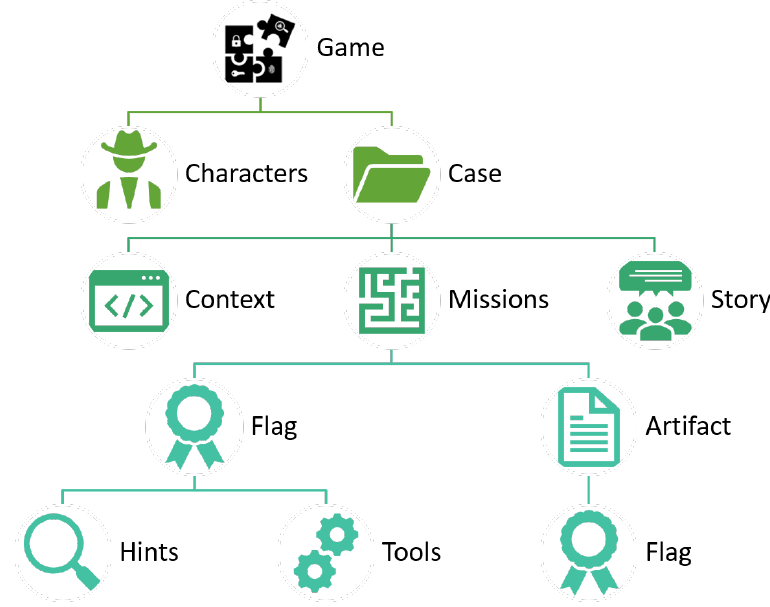
Figure 3. Conceptual structure of the game definition in CyberScratch.